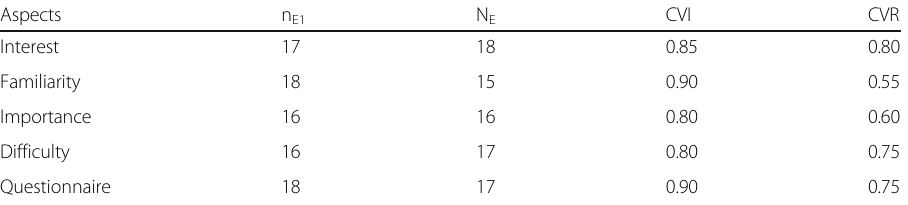
Table 1 Content Validity Ratio of Validated Questionnaires for Learners ’ Perception of Self-Selected